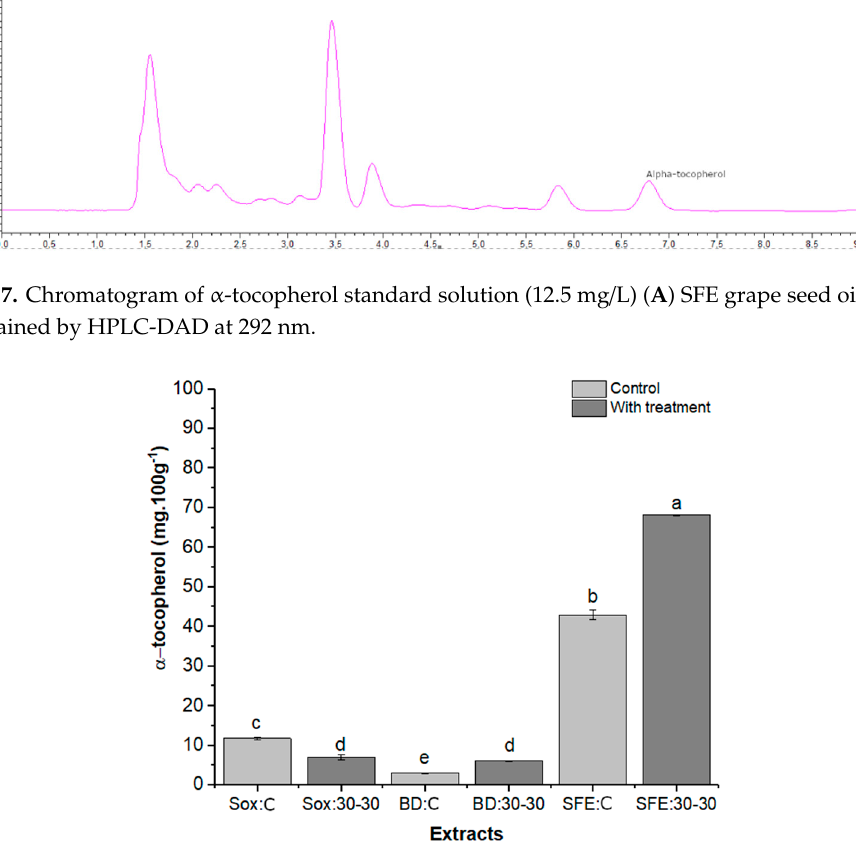
Figure 8. Concentration of α -tocopherol (mg/100 g oil) obtained for grape seed oil submitted to Sox, BD and SFE extractions. Data refer to results for the oil sample without pretreatment (C) and pretreatment (30:30) using ultrasound. The bars in each column represent the standard error. Samples with the same letter show no significant difference (p > 0.05) by the Tukey test with 95% confidence.